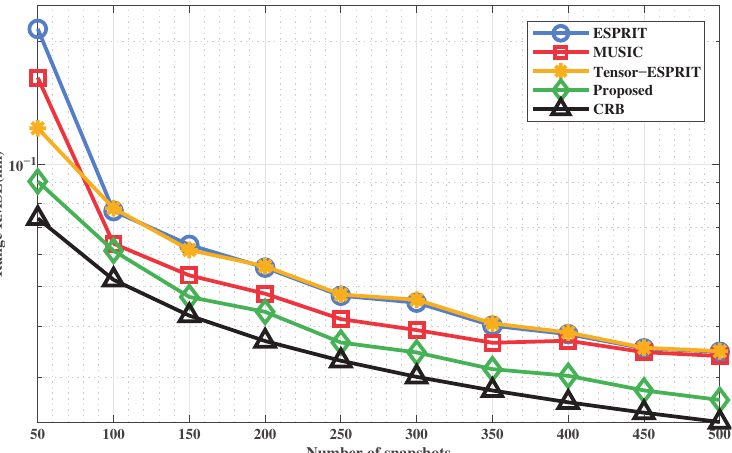
Figure 8. RMSE of range estimation versus